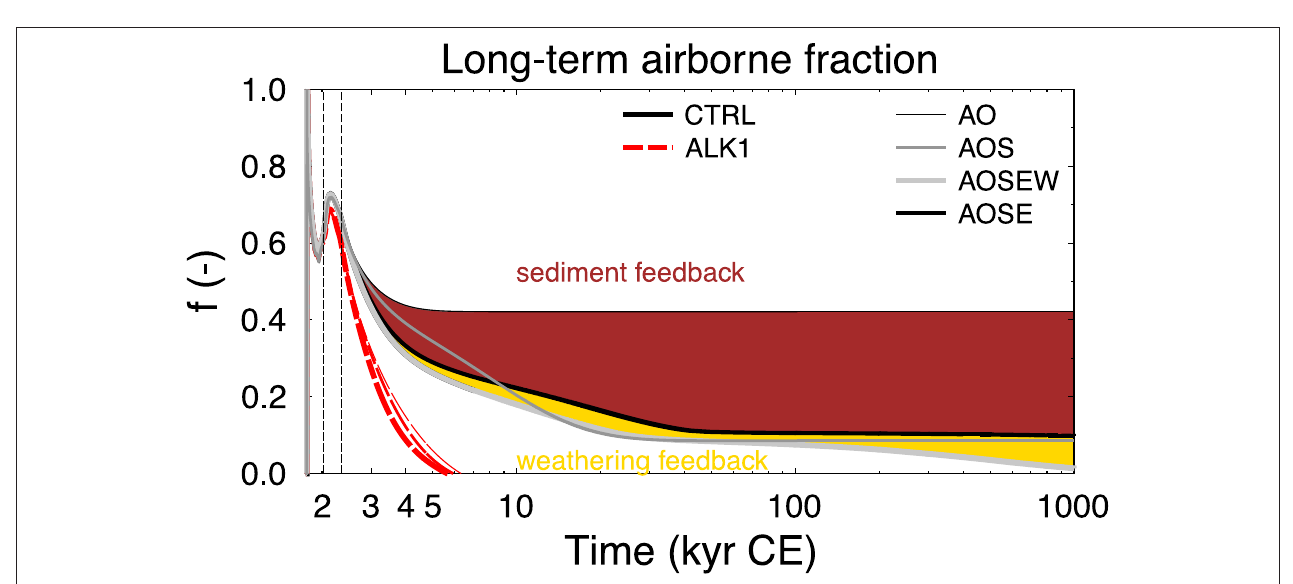
FIGURE 5 | Feedback analysis of the contribution of the positive temperature feedback, and the negative weathering and sediment feedback on the CTRL run and alkalinization scenario ALK1. Vertical lines are at 2020 CE (onset of alkalinization) and 2350 CE (emissions back to 0). Note log x-axis.